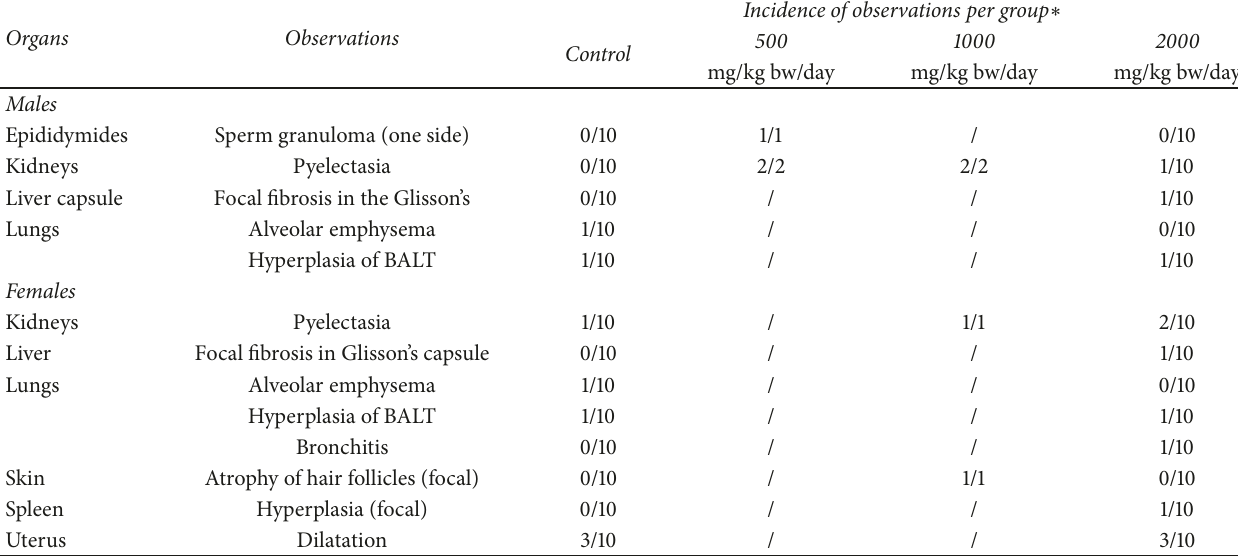
Table 9: Summary of histopathology findings in the 90-day